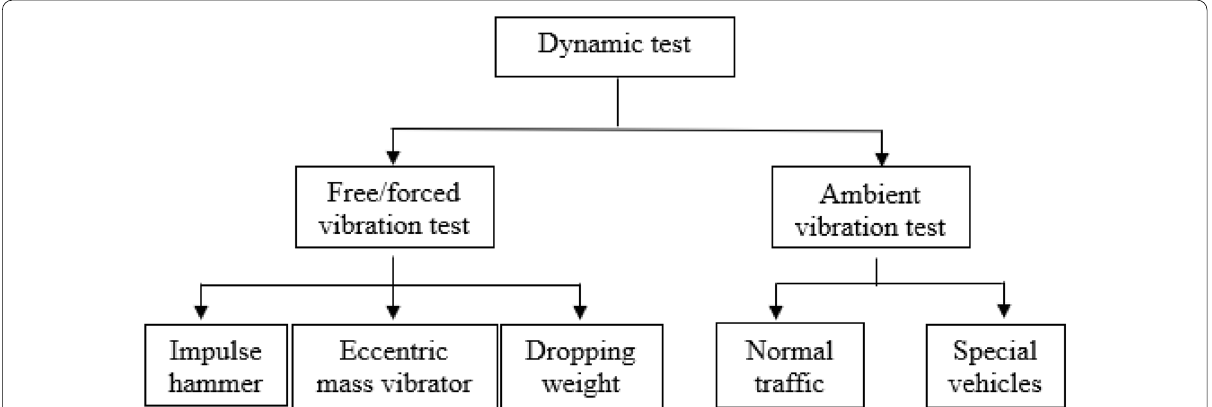
Fig. 2 Illustration of the excitation instrument based on the characterisation of the dynamic test